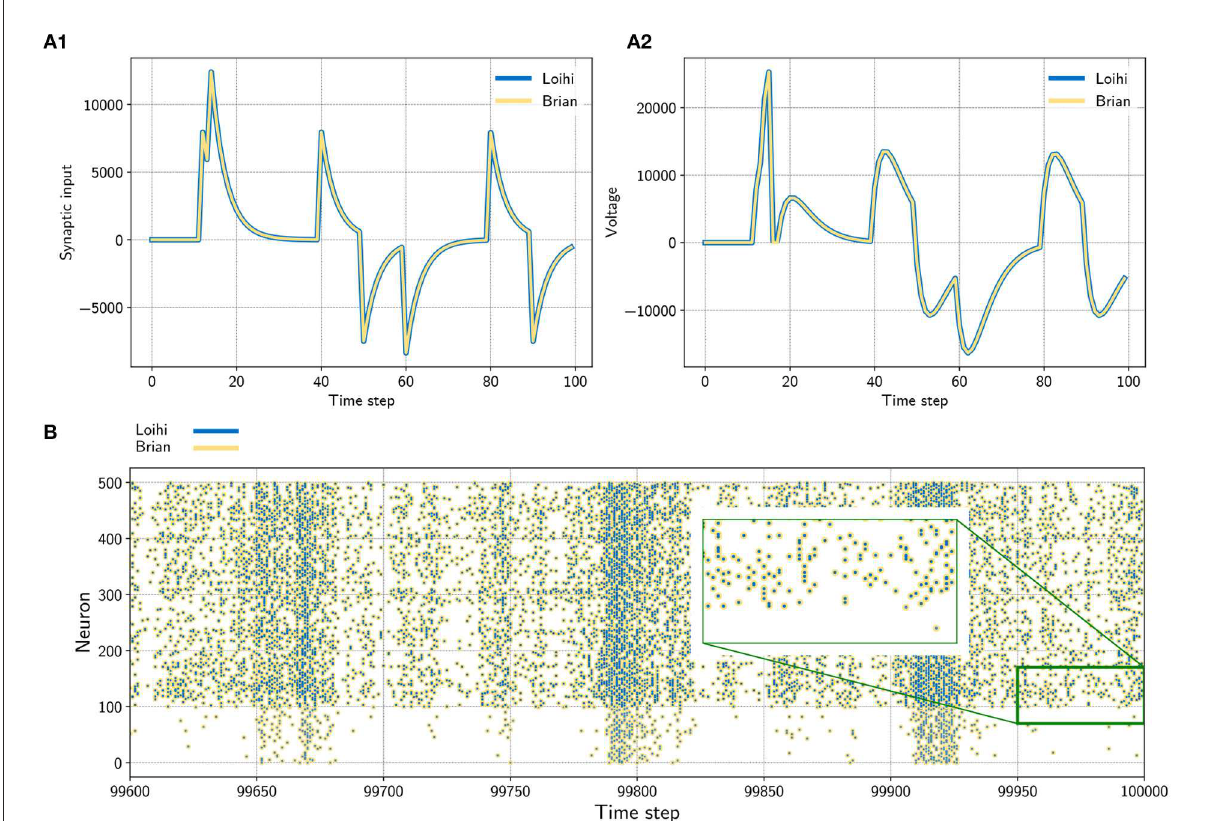
FIGURE1 (A) Input trace of a single synapse (left) and voltage trace (right) of a neuron. The neuron receives randomly timed excitatory and inhibitory input spikes. The emulator (yellow) matches Loihi (blue) in both cases perfectly. Note that Loihi uses the voltage register to count refractory time, which results in a functionally irrelevant difference after a spike, e.g time step 17 in A2 (see Appendix 9.2.2). (B) Network simulation with 400 excitatory (indices 100 − 500) and 100 inhibitory (indices 0 − 100) neurons. The network is driven by noise from an input population of 40 Poisson spike generators with a connection probability of 0.05. All spikes match exactly between the emulator and Loihi for all time steps. The figure shows the last 400 time steps from a simulation with 100,000 time